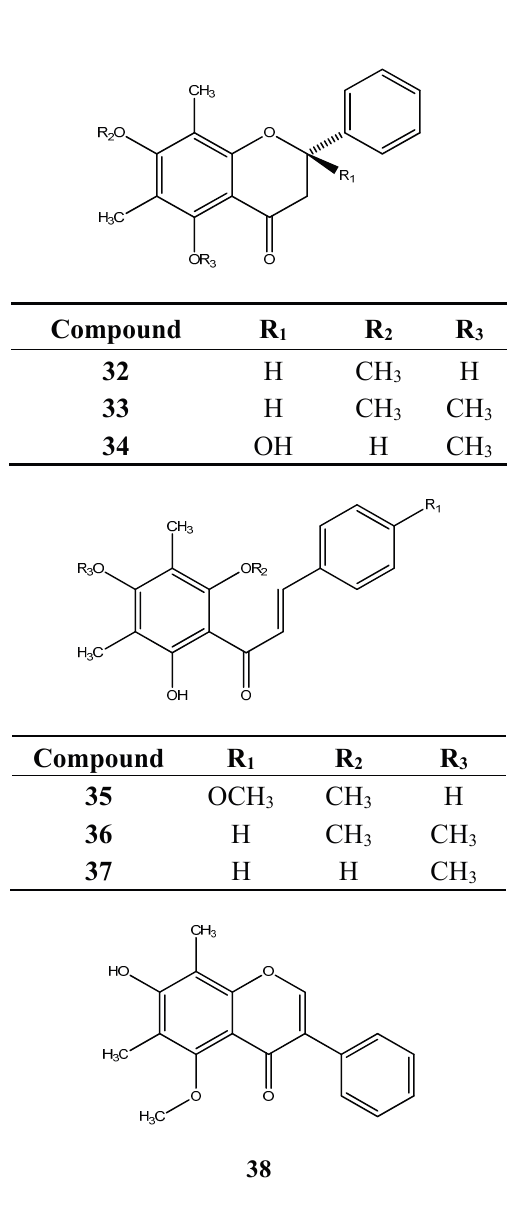
Figure 3. Other flavonoids and derivatives isolated from Myrcia